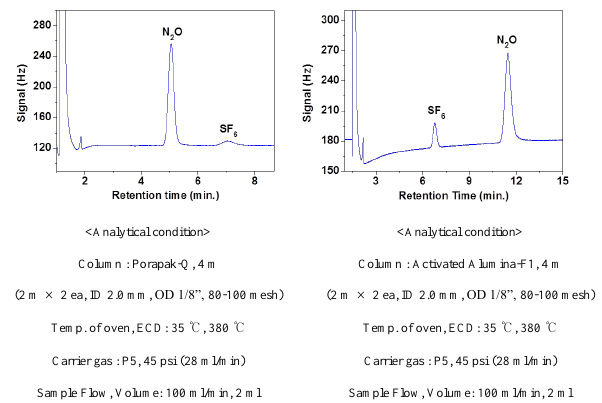
Figure 2 Chromatograms taken using the GC-ECD coupled with two different types of 1 Fig. 2. Chromatograms taken using the GC-ECD coupled with two different types of columns installed in the GC.